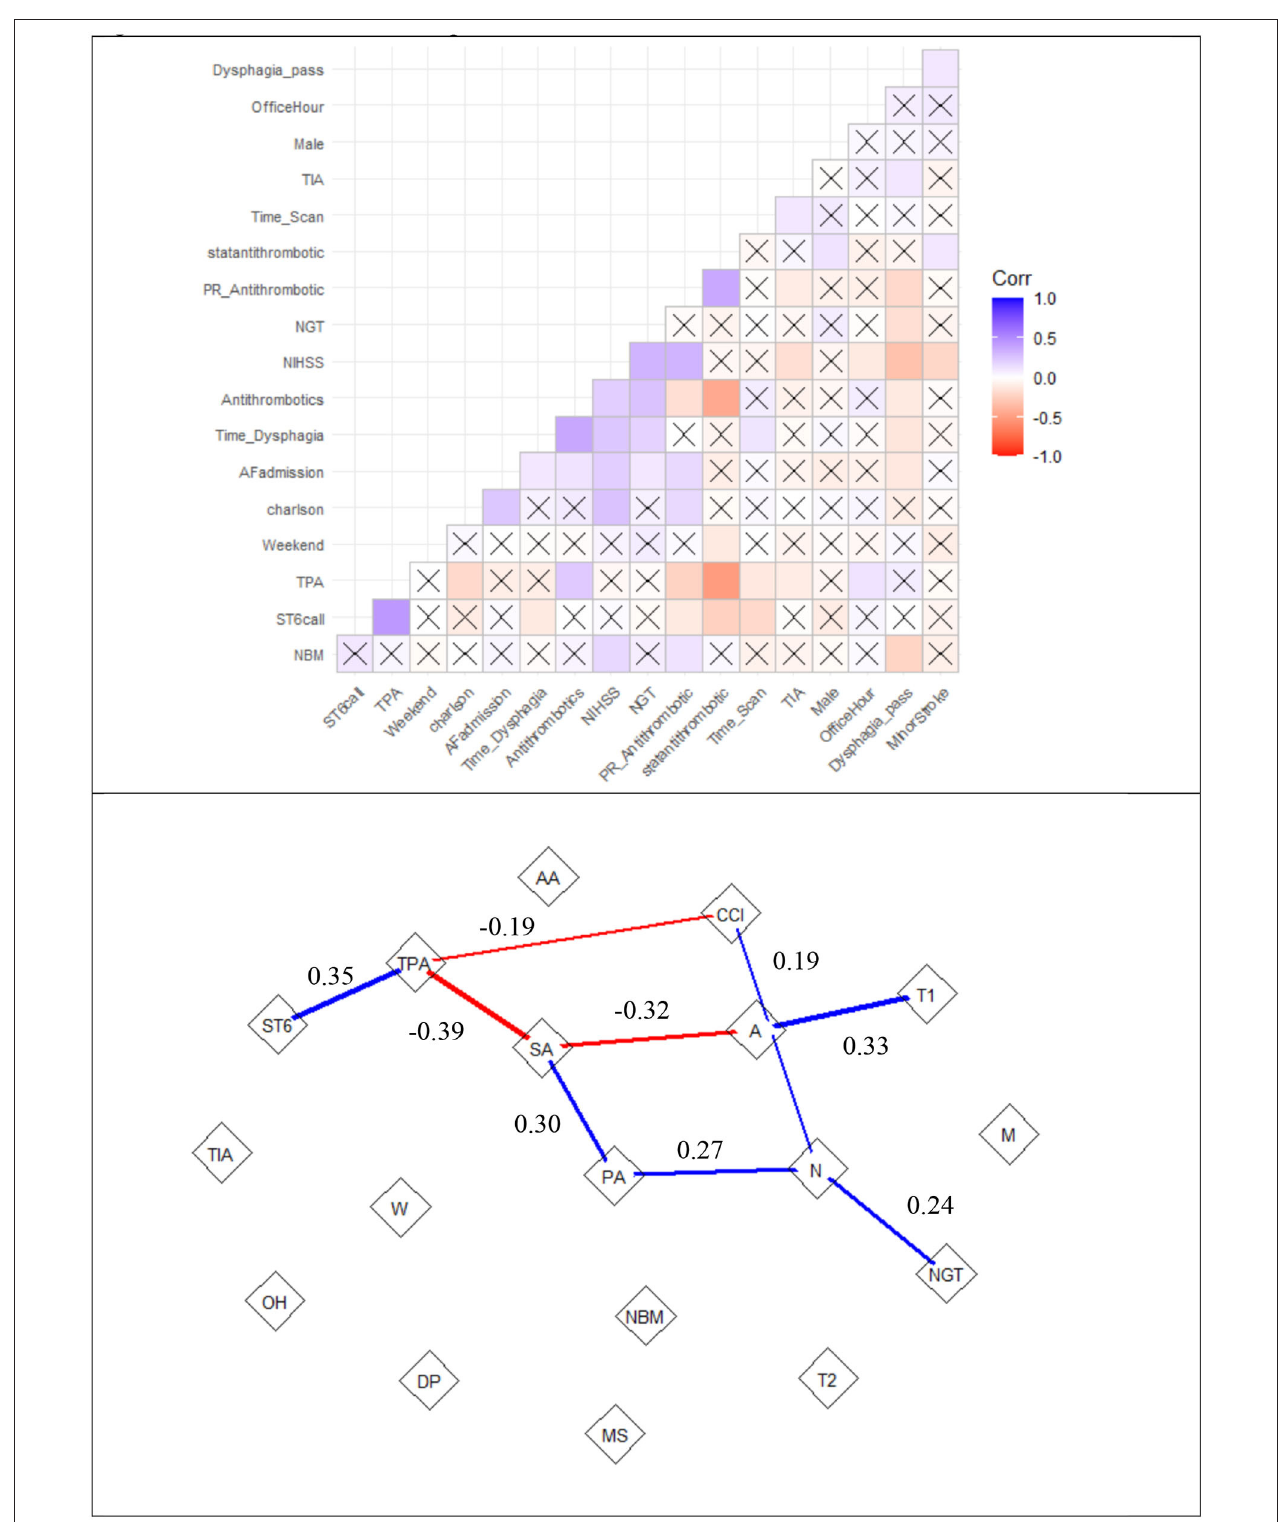
FIGURE 4 | Correlation matrix and partial correlation network of time to antithrombotics. the top row is the correlation matrix. Positive correlations are labeled in blue and negative correlations are in red. The thickness of the line represents the strength of the partial correlation. The “X” represents low correlation (0.0007), such